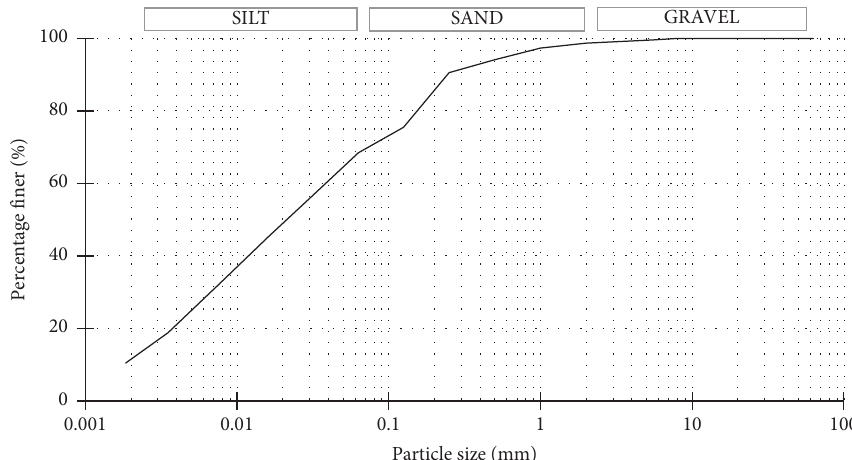
Figure 1: Particle size distribution of soil.